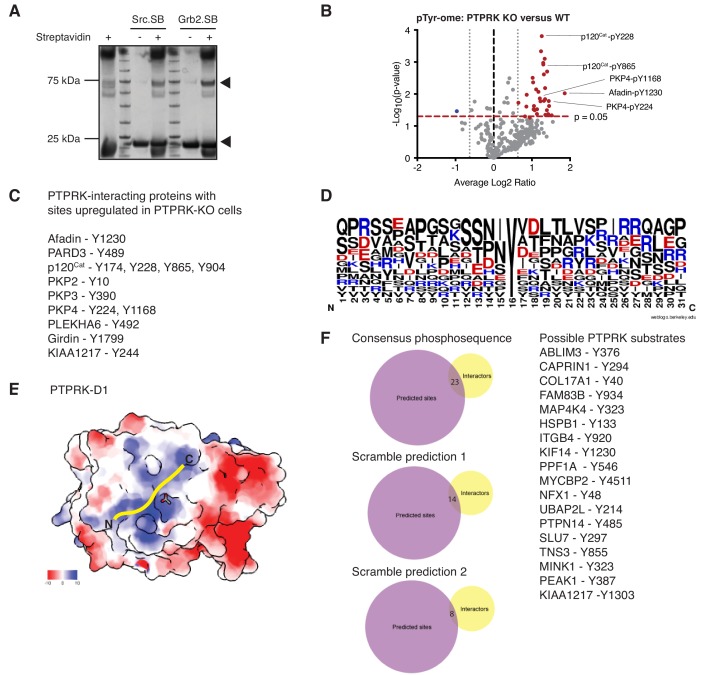
The PTPRK-dependent tyrosine phosphoproteome.(A) After SEC, proteins were incubated with or without streptavidin and subjected to SDS PAGE followed by Coomassie staining to determine the extent of biotinylation. Arrows indicate the purified domains and the respective streptavidin-induced mobility shift. (B) Volcano plot of tyrosine phosphosites detected in PTPRK KO and wildtype MCF10As. Phosphosites > 50% enriched in (p<0.05; n = 3) in PTPRK KO cells are labeled red and those enriched in wildtype are blue. FDR = 0.01, one valid value required. (C) Proteins with upregulated phosphotyrosine sites in PTPRK KO cells that were also identified as PTPRK interactors, either by proteomics or immunoblotting. (D) Weblogo representation of amino acids surrounding phosphotyrosine from candidate substrates in (C). (E) Surface charge representation of PTPRK-D1 (left; PDB: 2C7S Eswaran et al., 2006) showing acetate bound to the active site. Yellow line represents the approximate binding location for a ~ five amino acid phosphopeptide. Scale indicates kcal/mol·e. (F) Phopshopeptide motifs derived from PTPRK candidate substrates ([STEADNR][NPDHLRTY][INSEPGV]pY[VADIEFGSY][DTEGIKNQRS][LFPSTANR]) were used to search the phosphosite plus database. Scramble 1 and 2 correspond to the following searches: [LFPSTANR][DTEGIKNQRS][VADIEFGSY]pY[INSEGPV][INSEGPV][STEADNR] and [INSEGPV][NPDHLRTY][STEADNR]pY[LFPSTANR][DTEGIKNQRS], respectively. Listed are PTPRK-interacting proteins with phosphosites predicted by the consensus. Number of overlapping proteins between phosphosite plus searches and interactors are shown on Venn diagrams.